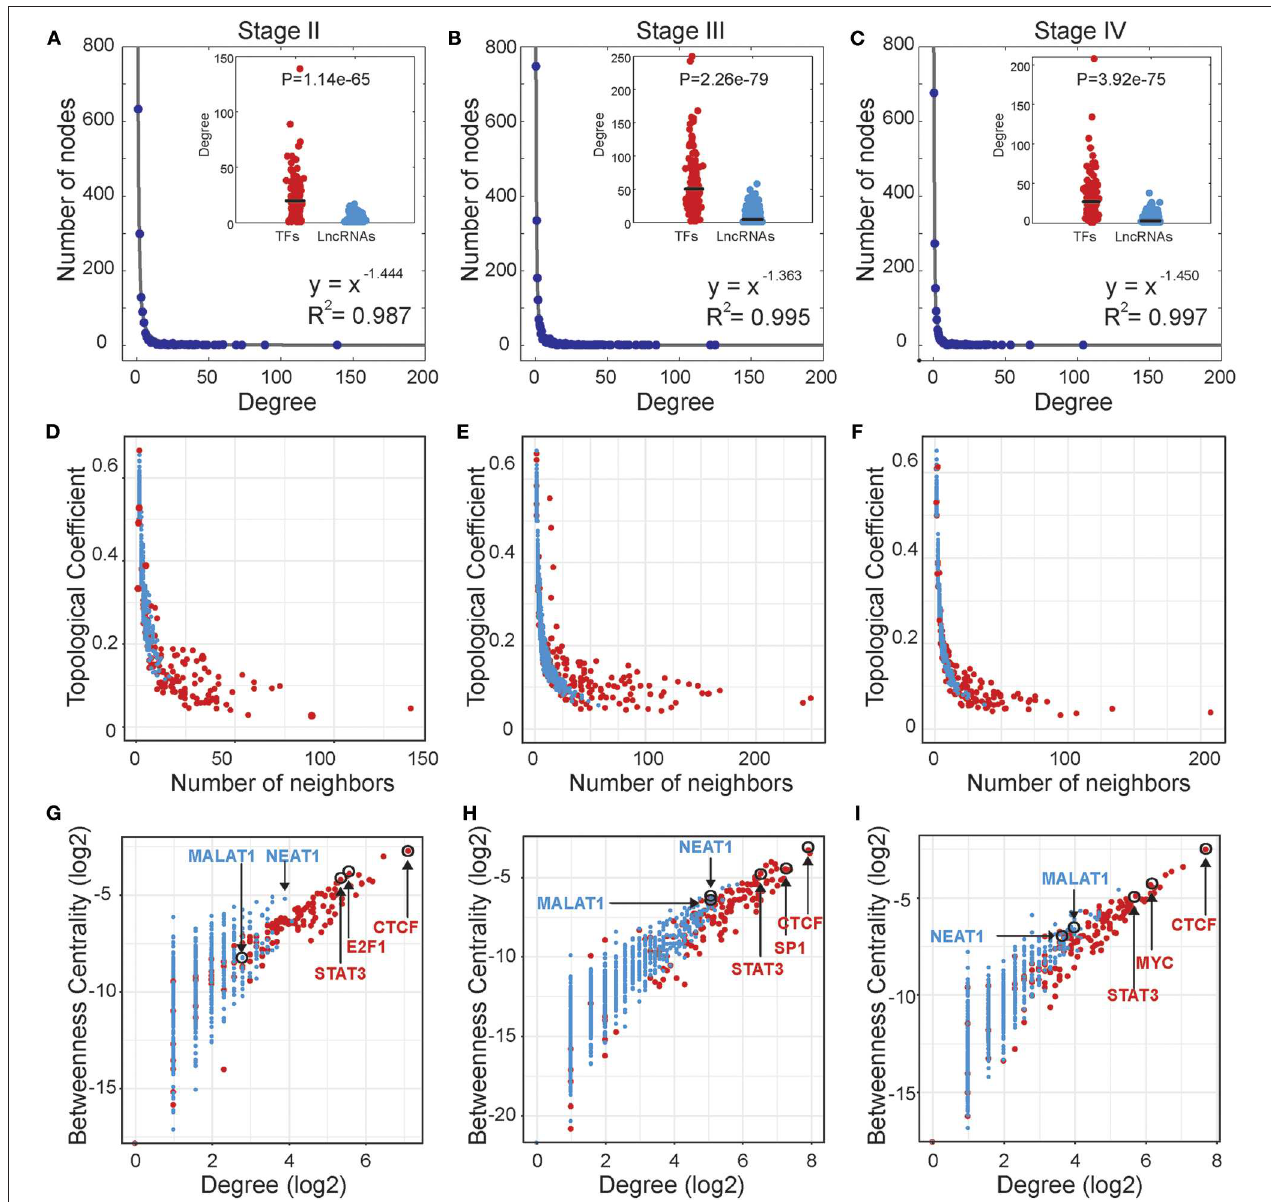
FIGURE 2 | Topological properties of stage-specific TF-lncRNA regulatory networks. (A–C) The degree distributions of nodes in the three networks. The TF nodes have significantly higher degree values than lncRNA nodes in each stage. (D–F) The topological coefficients decreased with the increase in number of neighbors. (G–I) Some well-known OC risk TFs and lncRNAs can be found in the TF-lncRNA networks and exhibit higher values of betweenness centrality and degree.